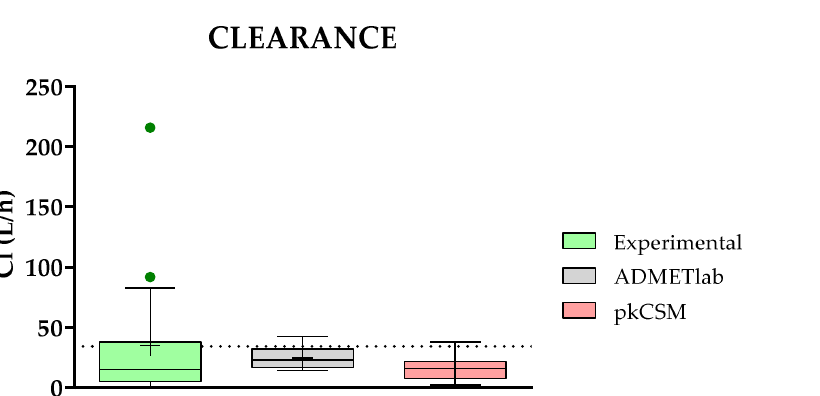
Figure 9. Comparison of experimental and predicted data for clearance (Cl) between ADMETlab and pkCSM. Statistical analysis was performed by a pairwise t -test ( n = 19) versus experimental data.